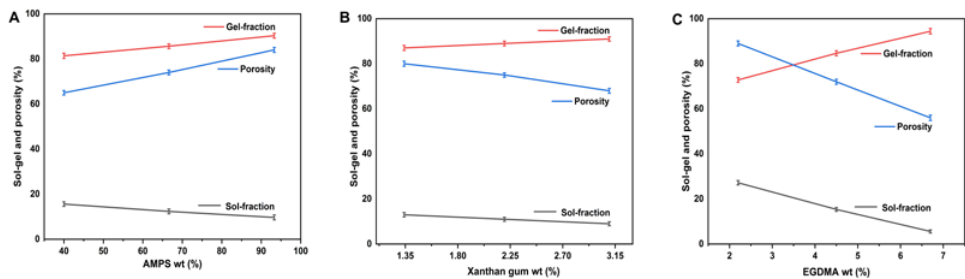
Figure 7. Effect of AMPS ( A ), EGDMA ( B ), and xanthan gum ( C ) on sol–gel and porosity of the fabricated hydrogels [82,83].